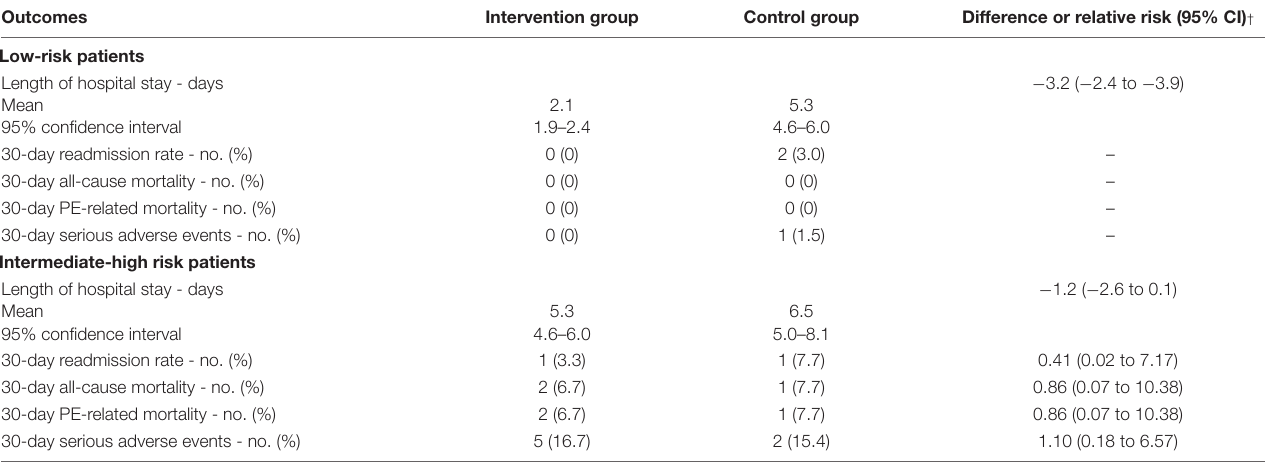
TABLE 2 | Outcomes according to subgroups of risk